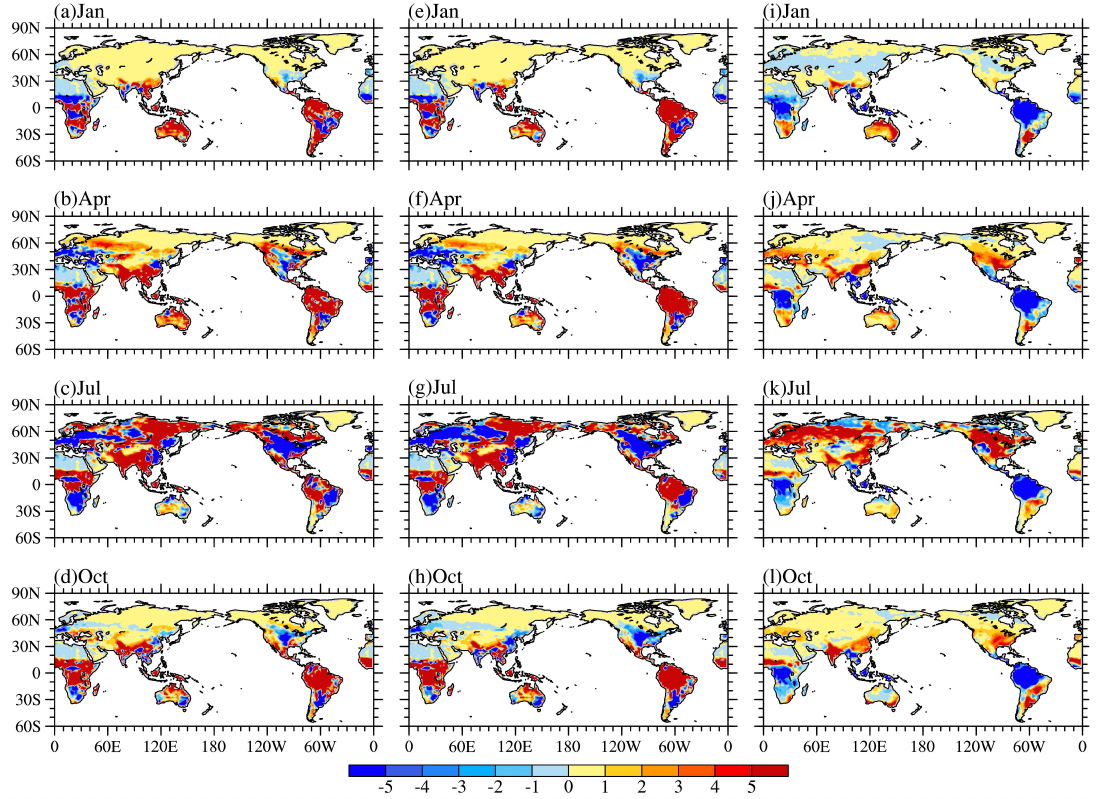
Figure 7. Spatial distribution of global Et (units: W/m 2 ): ( a – d ) difference between CLM4.5 and NOAA, ( e – h ) difference between CLM4.0 and NOAA, and ( i – l ) difference between CLM4.5 and